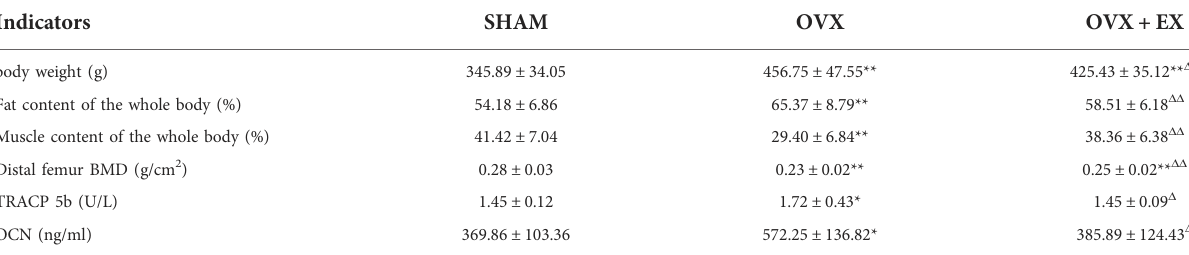
TABLE 1 Comparison of body weight, body composition, bone mineral density and bone metabolism indicators of rats in each